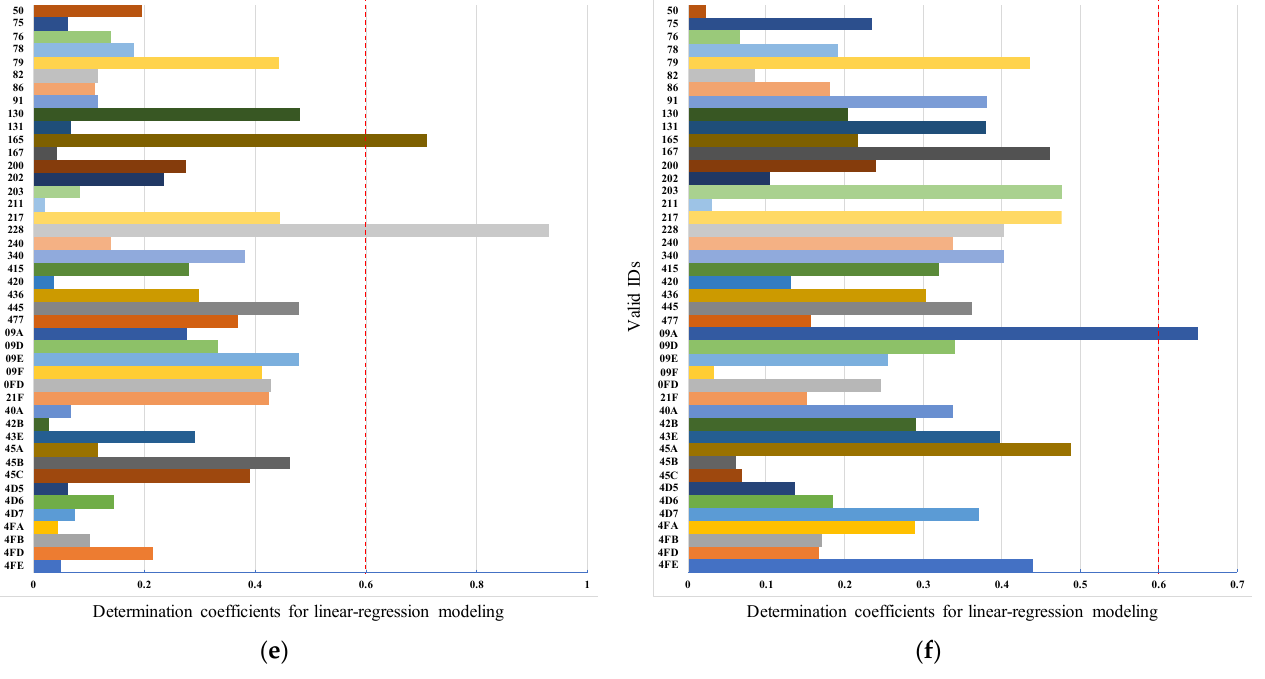
Figure 11. Real vehicle messages filter results: ( a ) speed-related messages; ( b ) steer angle-related messages; ( c ) gas pedal-related messages; ( d ) brake pedal-related messages; ( e ) gear-related messages; ( f ) wiper related-messages.